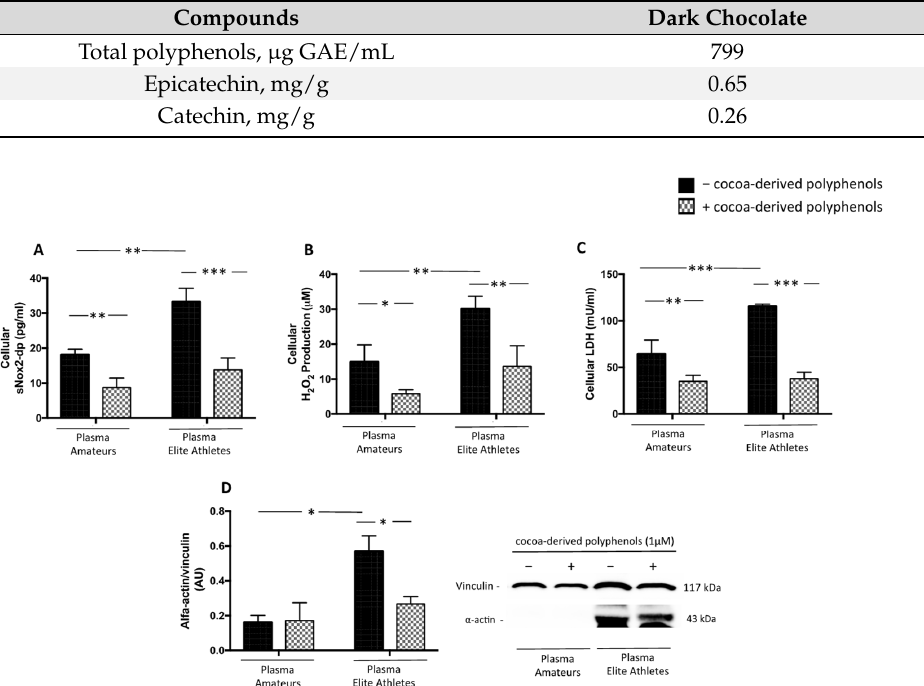
Figure 7. Oxidative stress and muscle injury biomarkers in supernatants of HSMM-plasma co-cultures. H 2 O 2 levels ( A ), sNOX2dp concentration ( B ), LDH ( C ) and α -actin expression ( D ) were evaluated in supernatants of HSMM (Human Skeletal Muscle Myoblast) cell cultures treated with plasmas taken from amateurs (n = 3) and elite athletes (n = 3) in the presence or not of cocoa-derived polyphenols. (Data are represented as mean ± standard deviation) (*** p < 0.001, ** p < 0.01, * p < 0.05).